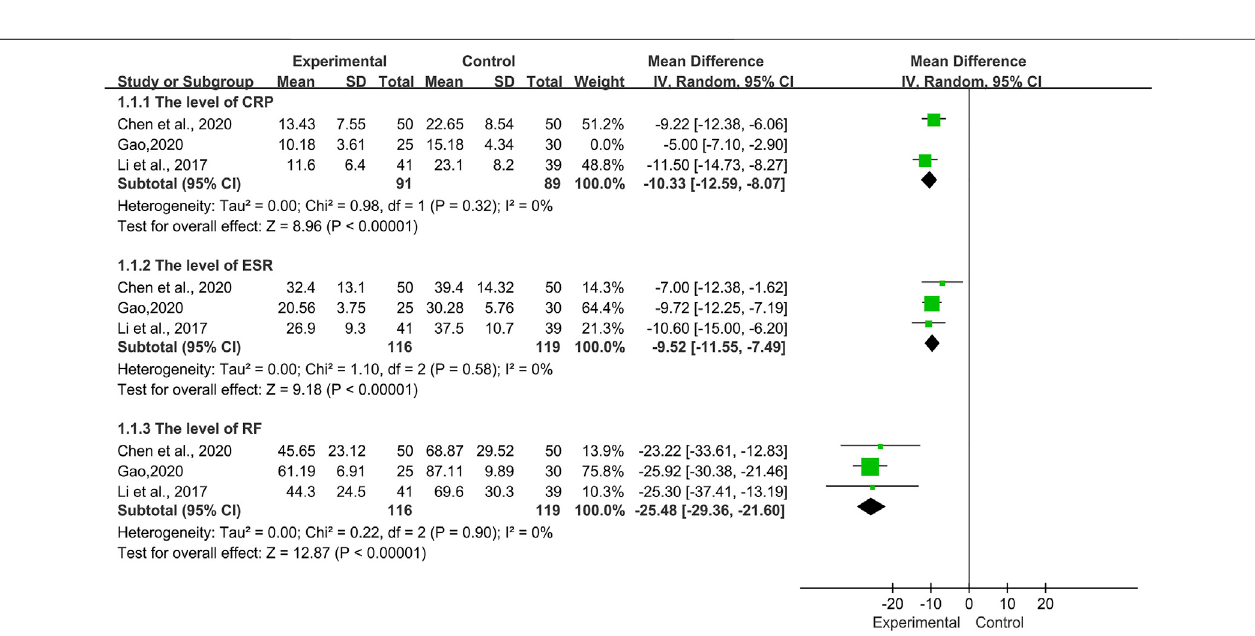
FIGURE 11 | Forest plot of sensitivity analysis of laboratory indicators with TwHF combined with conventional treatment versus pure conventional treatment.